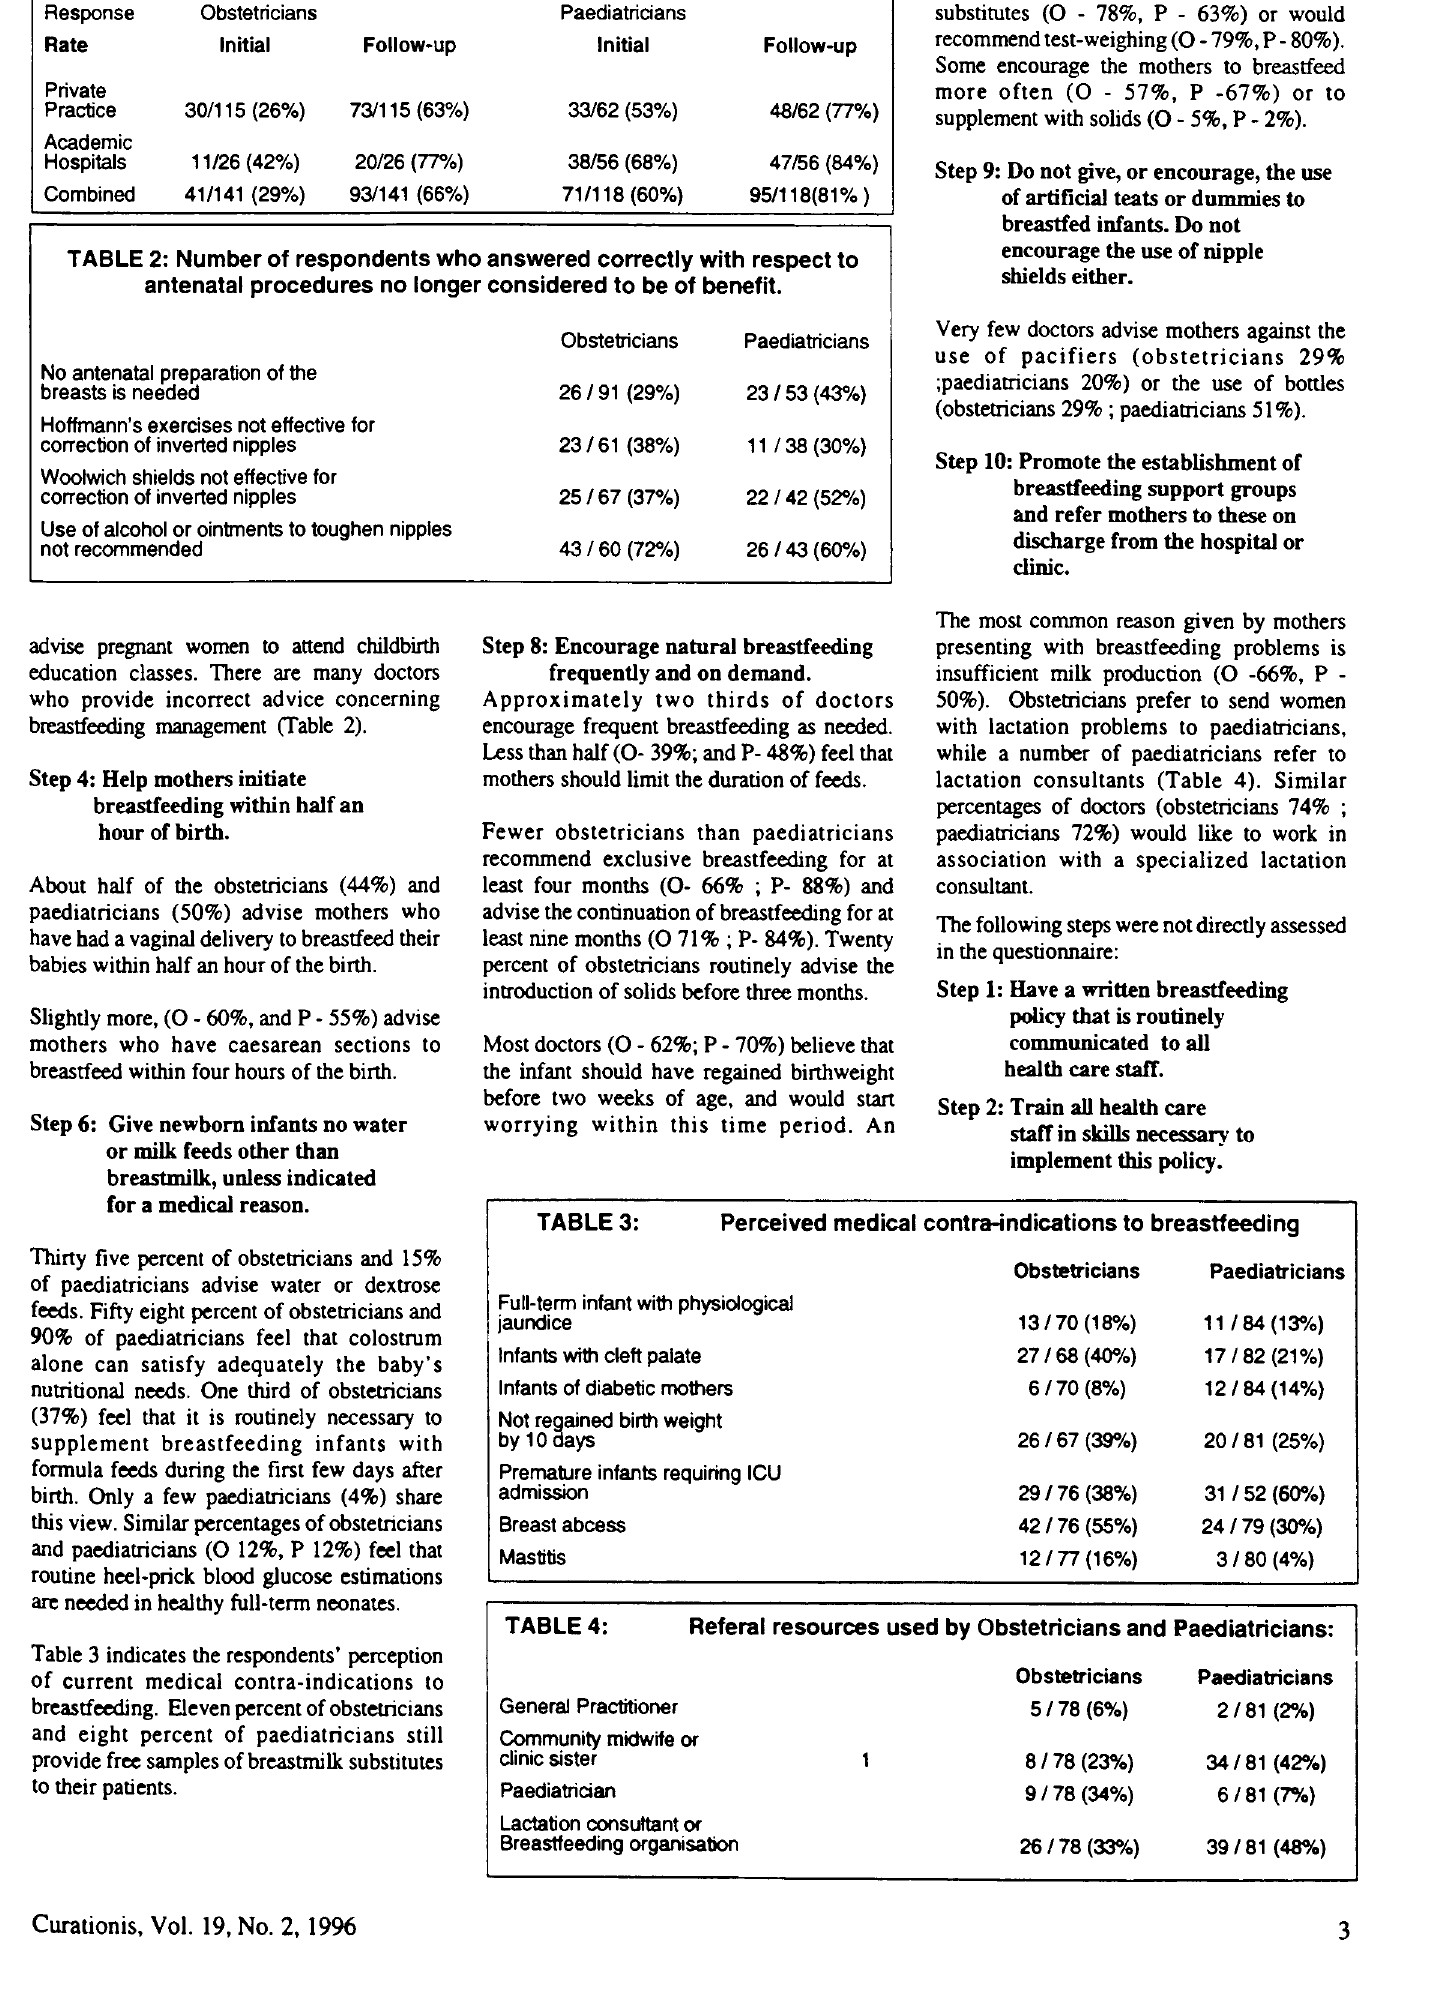
TABLE 2: Number of respondents who answered correctly with respect to antenatal procedures no longer considered to be of benefit.